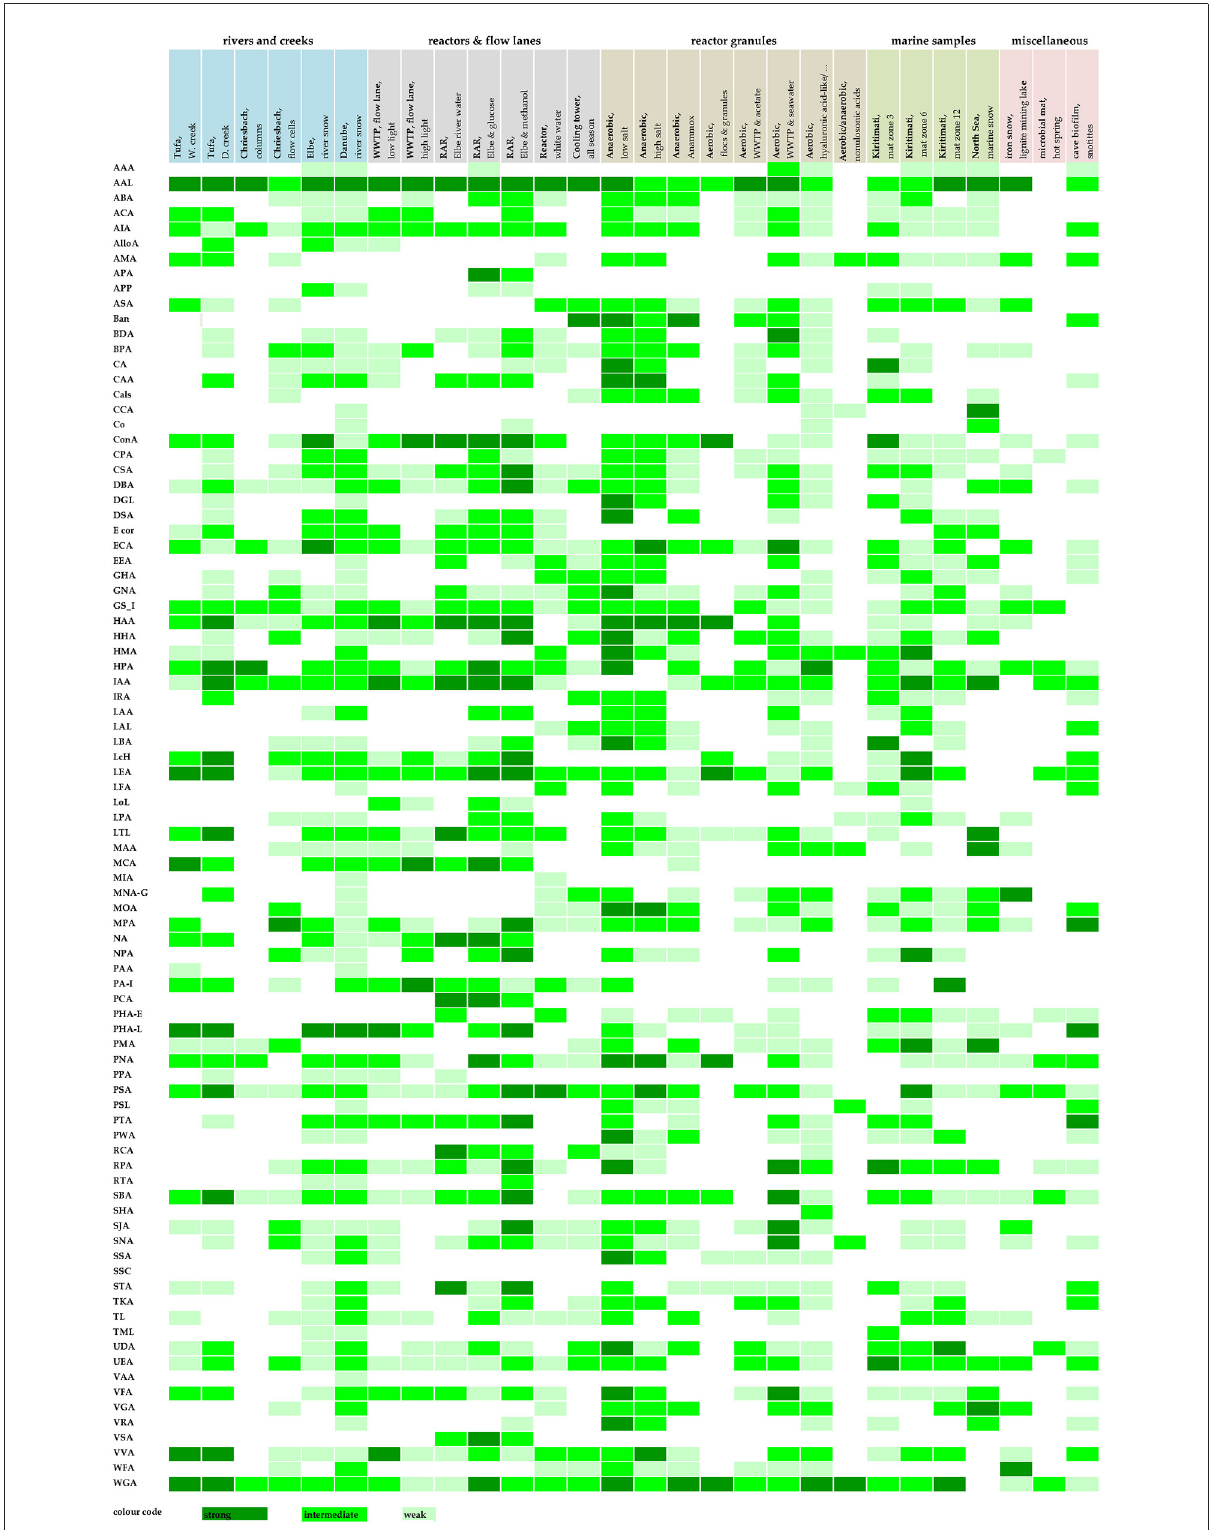
FIGURE2 Detailed barcoding results of the lectin screening (FLBC) by means of a three color heat map. The signal intensities were color-coded equal to signal intensity: high signal (PMT voltage 400–600), intermediate signal (PMT voltage 600–800), and low signal (PMT voltage 800–1,000). Color coding: strong lectin binding–dark green, intermediate lectin binding–bright green, and low lectin binding–soft green. For abbreviations of lectins, see Supplementary Table